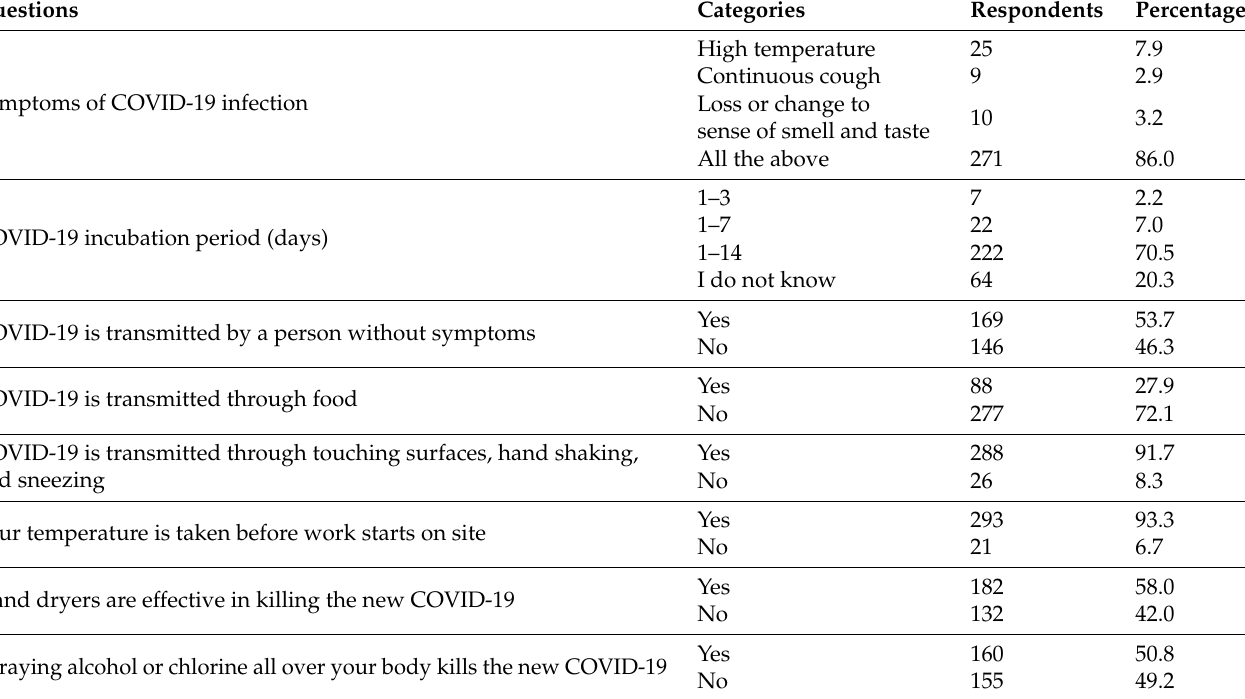
Table 2. Food service staff information on the symptoms and transmission of COVID-19.